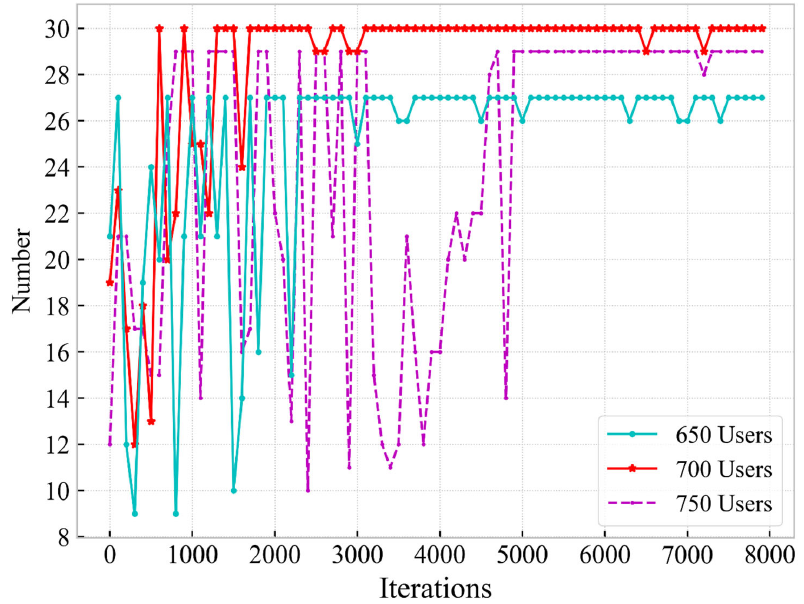
Figure 11. The comparison of the number of dual ‐ connected users under different numbers of users.